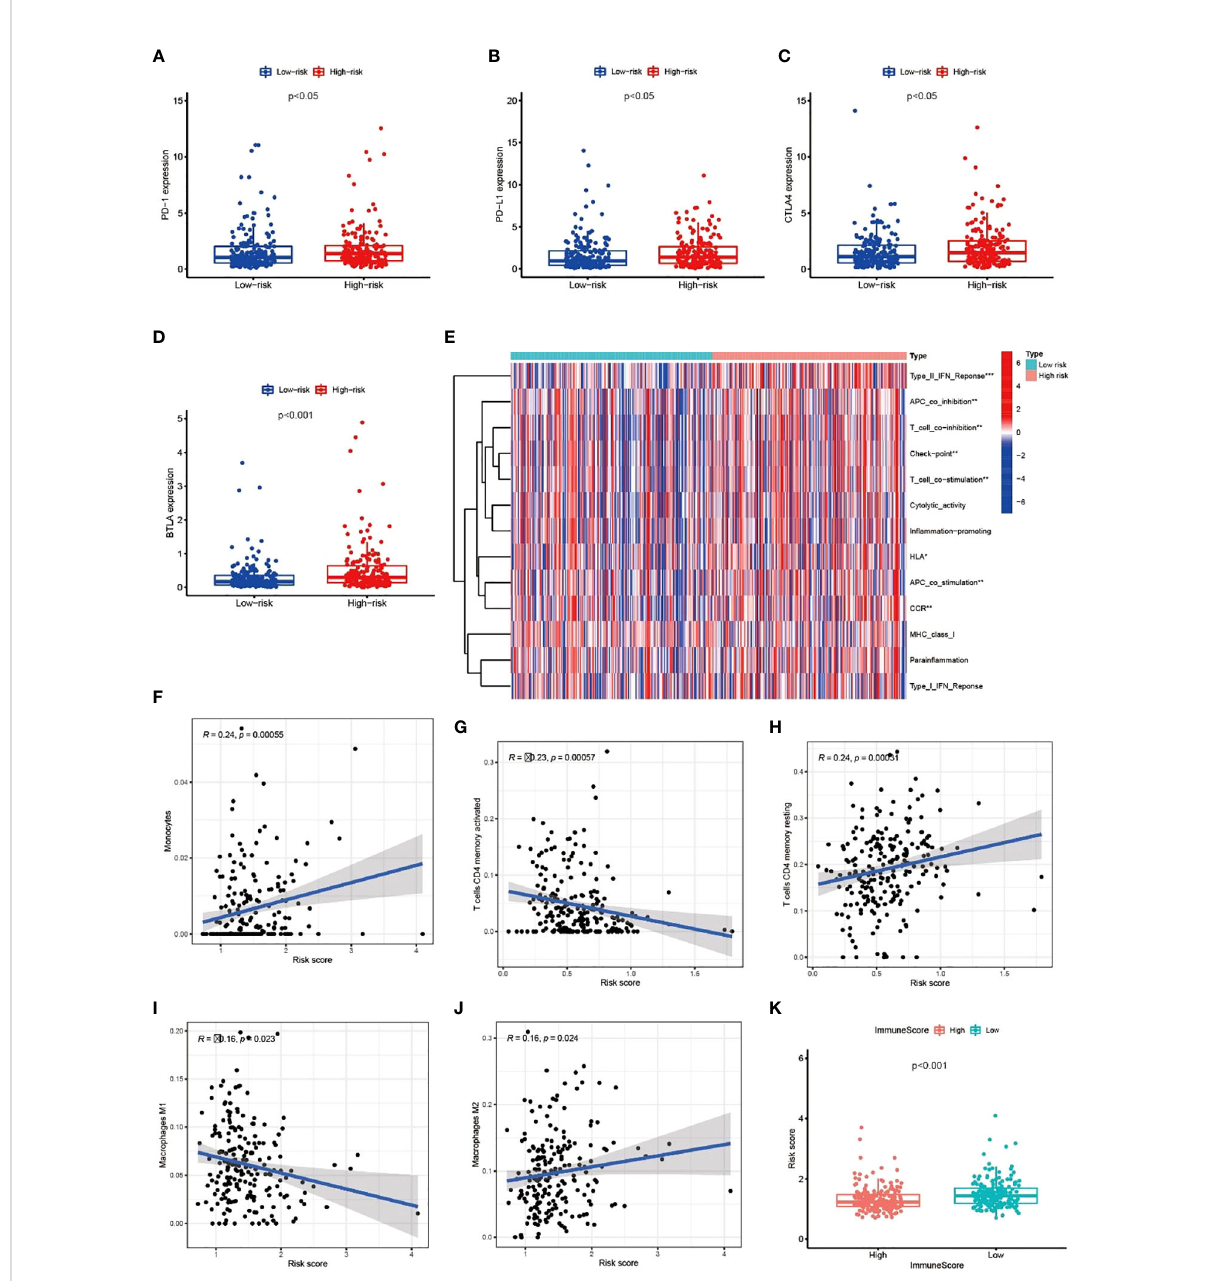
FIGURE 9 Metabolic lncRNAs risk model re fl ected the immune microenvironment (A – D) The relationship between immune checkpoint molecules and risk scores. (E) Heatmap of differences in immune function between high- and low-risk group. (F – J) The relationship between immune cell types and risk scores. (K) Boxplot of relationship analysis of risk score and ImmuneScore. *p < 0.05,**p < 0.01, ***p <